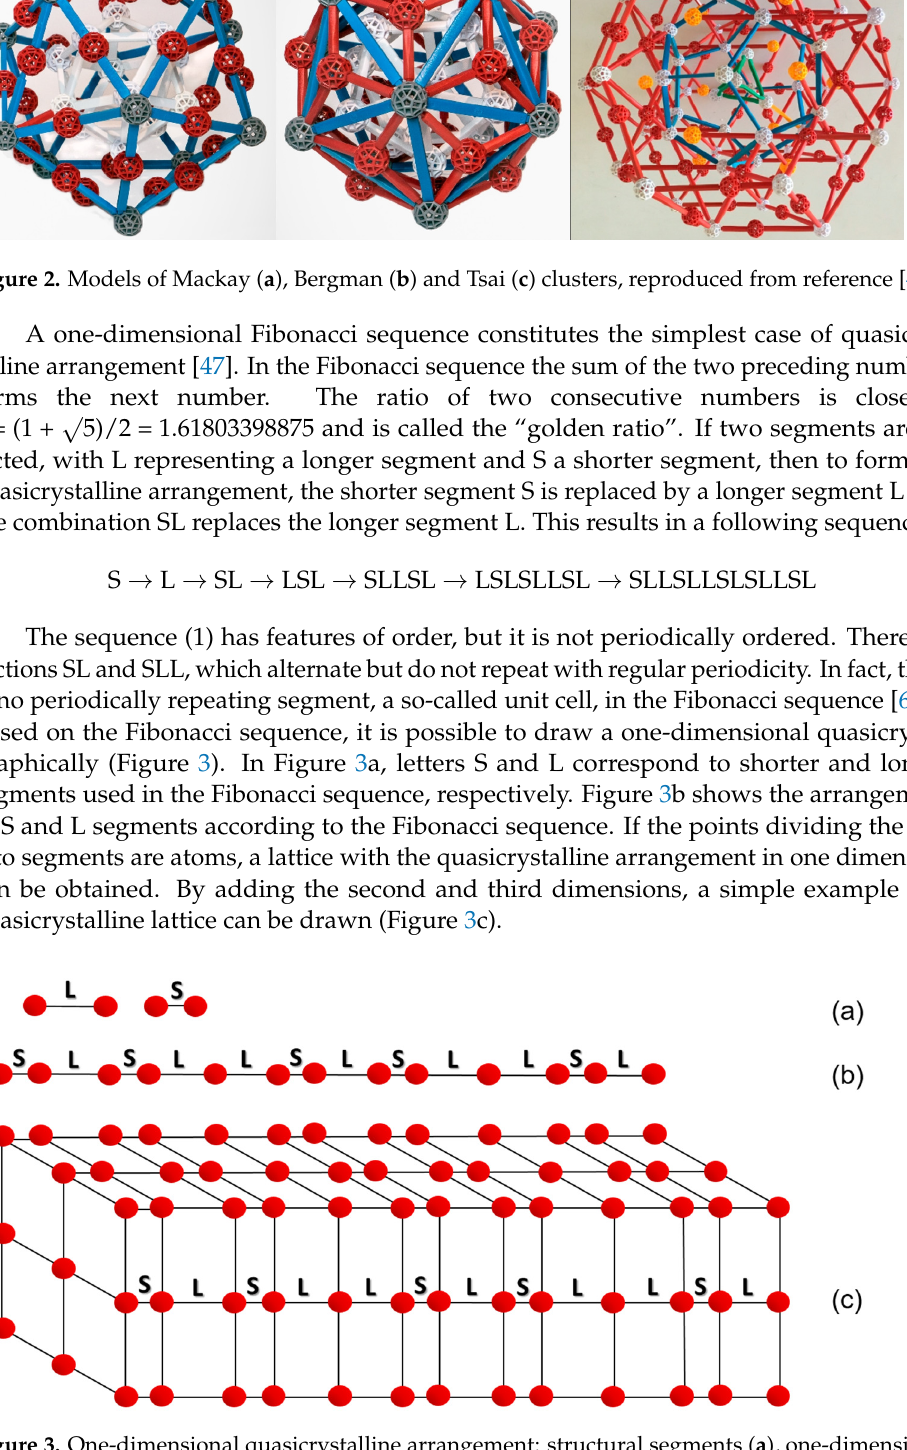
Figure 3. One-dimensional quasicrystalline arrangement: structural segments ( a ), one-dimensional quasiperiodicity ( b ), and simple quasicrystal in three-dimensional space ( c ). The quasiperiodic arrangement in two-dimensional space can be represented by Pen- rose tiling [9,45]. This arrangement consists of two tiles that do not repeat periodically in two-dimensional space. The construction is given by two basic units: a wider rhombus with acute angle α = 2 π /5 and a narrower rhombus with acute angle α = π /5. These tiles are arranged in shapes with a five-fold axis of symmetry. As with the Fibonacci sequence,